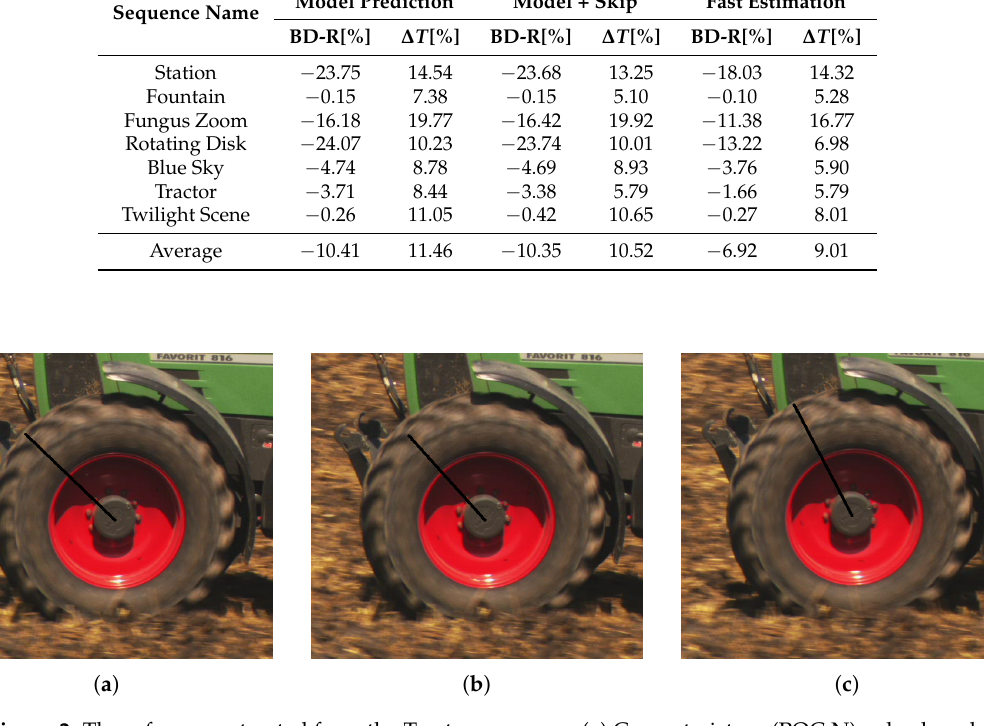
Figure 2. Three frames extracted from the Tractor sequence: ( a ) Current picture (POC N), wheel angle 136; ( b ) reference picture 0 (POC N-1), wheel angle 132; ( c ) reference picture 1 (POC N-4), wheel angle 118. While the wheel is in a more distant position in ( c ) than ( b ), an acceptable prediction can be done with ( c ) using the wheel rotational